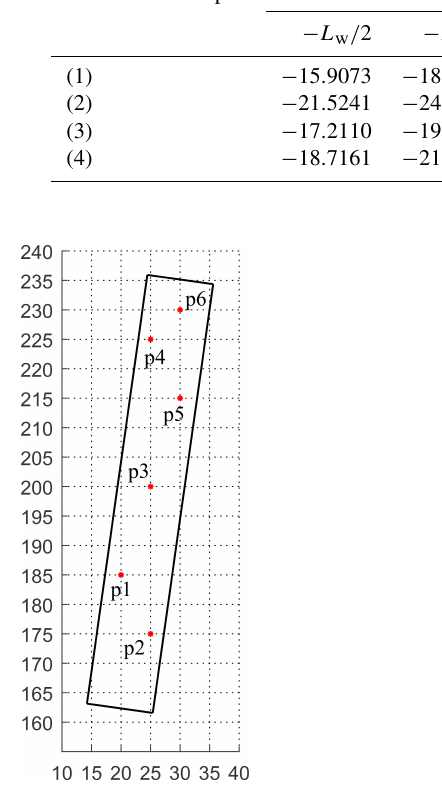
Table 5. Value of (cid:57) d at the inspection points on the e flank of the conical worm Numerical examples